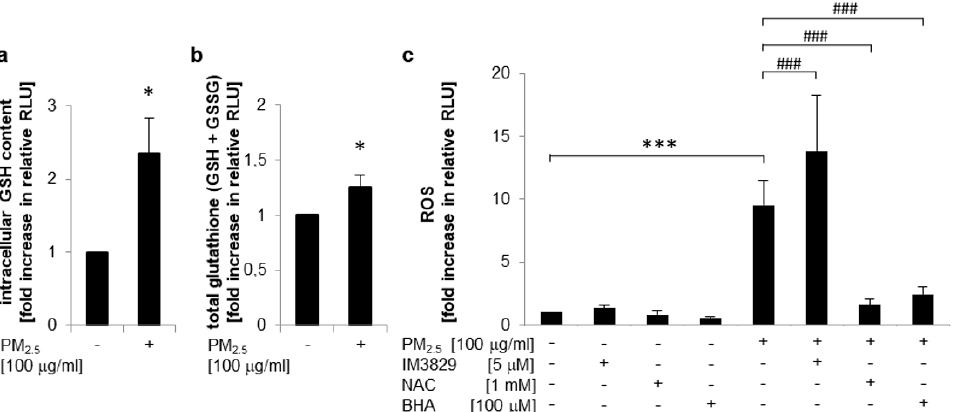
Figure 4. Nrf2 activation by PM 2.5 increases bioavailability of GSH and limits intracellular ROS levels. BEAS-2B cells were cultured in the presence of 100 µ g / mL PM 2.5 for 3 to 5 weeks, before final passage and re-exposure of cells to 100 µ g / mL PM 2.5 . ( a ) Intracellular GSH content or ( b ) increase in total amount of glutathione (GSH + GSSG) after 48 h of re-exposure with PM 2.5 , determined as GSH-associated fluorescence per µ g of protein compared to untreated control cells (n = 3). ( c ) Determination of intracellular ROS levels by a DCFH-DA assay using flow cytometry after 6 h of re-exposure with PM 2.5 (n = 3). The inhibitors BHA (100 µ M), IM3829 (5 µ M), or NAC (1 mM) were added 1 h prior to PM 2.5 re-exposure. RLU: relative light units. Values are depicted as means and + standard deviations, compared to untreated control cells: * p < 0.05; *** p < 0.001; compared to PM 2.5 -exposed cells: ### p < 0.001.